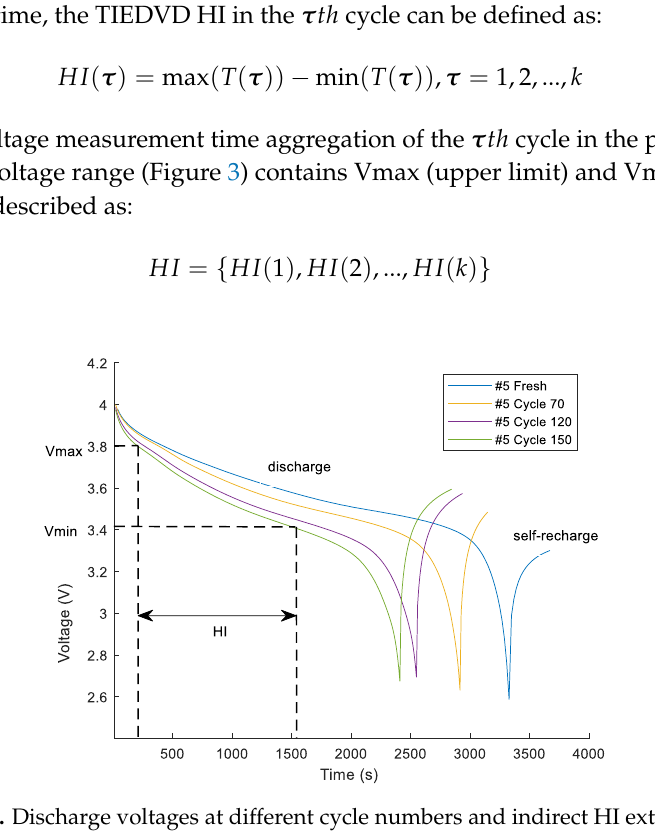
Figure 3. Discharge voltages at different cycle numbers and indirect HI extraction.